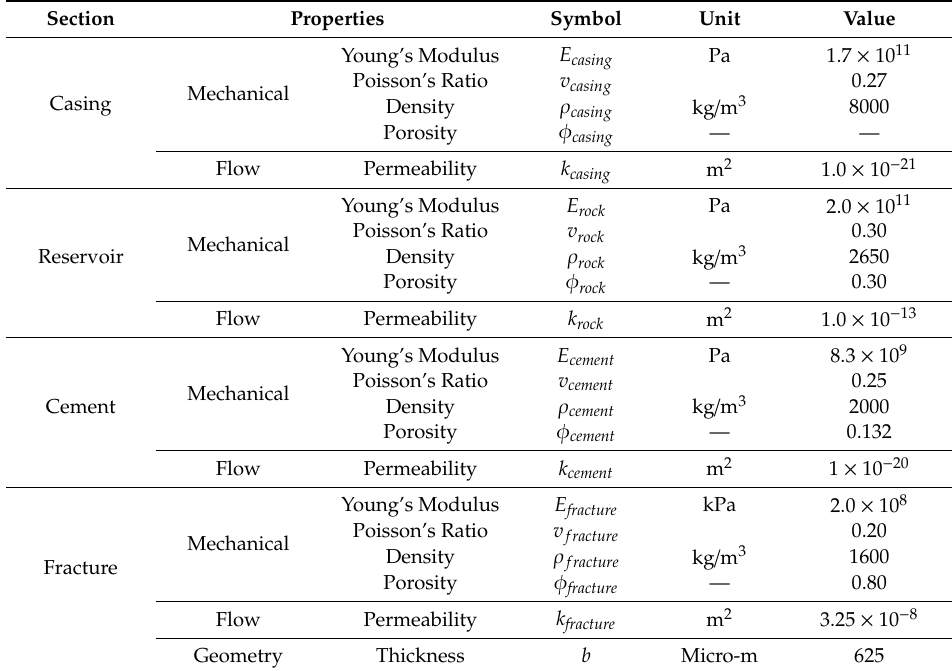
Table 6. Properties of casing, reservoir, cement, and